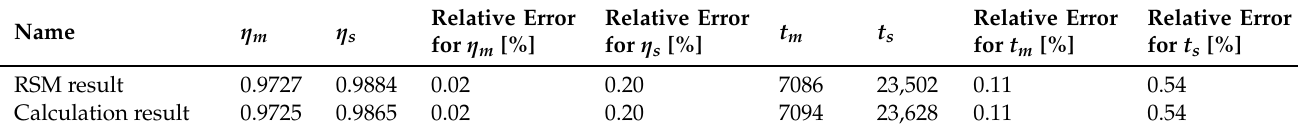
Table 6. Verification of optimisation